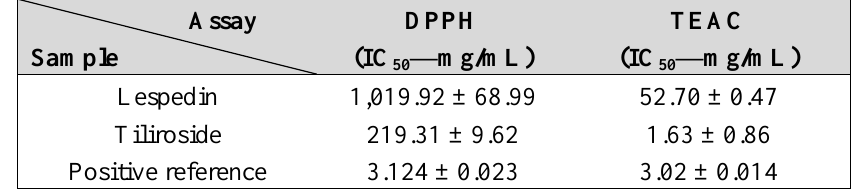
Table 5. DPPH radical scavenging activity and Trolox equivalent antioxidant capacity (TEAC) of Tiliroside e